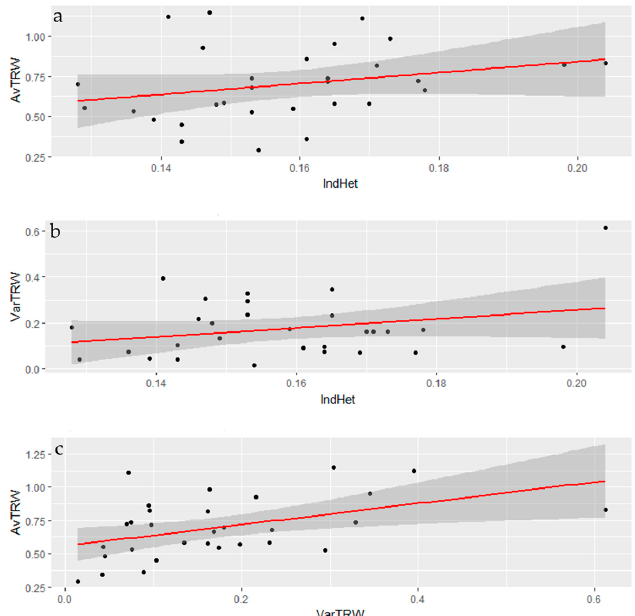
Figure 4. Regression analysis of ( a ) average tree-ring width (AvTRW) ( adjR 2 = 0.03743, intercept = 0.160, slope = 3.3995, p = 0.156); and ( b ) tree-ring variance (VarTRW) ( adjR 2 = 0.040, intercept = − 0.1369, slope = 1.9667, p = 0.148) with individual heterozygosity (IndHet), and ( c ) regression of AvrTRW with VarTRW. AvTRW and VarTRW were significantly associated with each other ( adjR 2 = 0.17818, intercept = 0.5583, slope = 0.7992, p = 0.012).